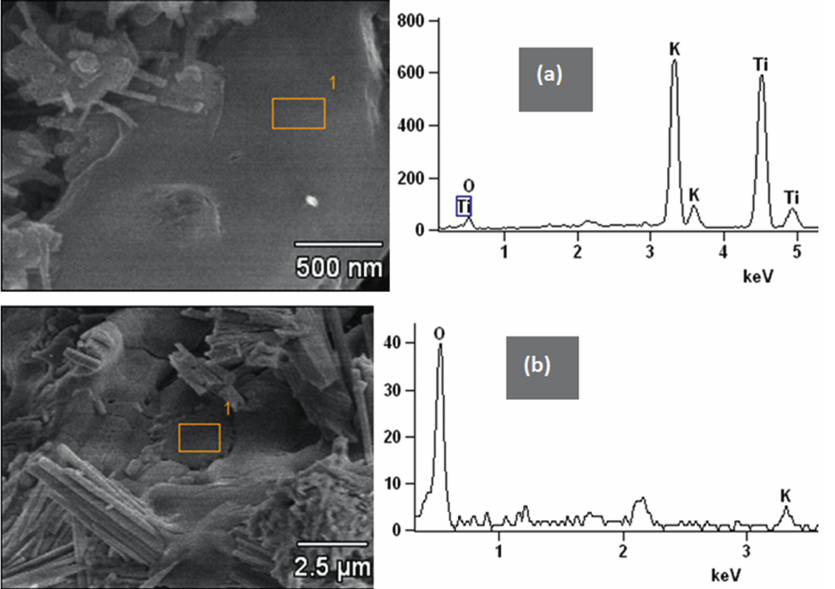
Figure 8: EDS images of K 2 Ti 4 O 9